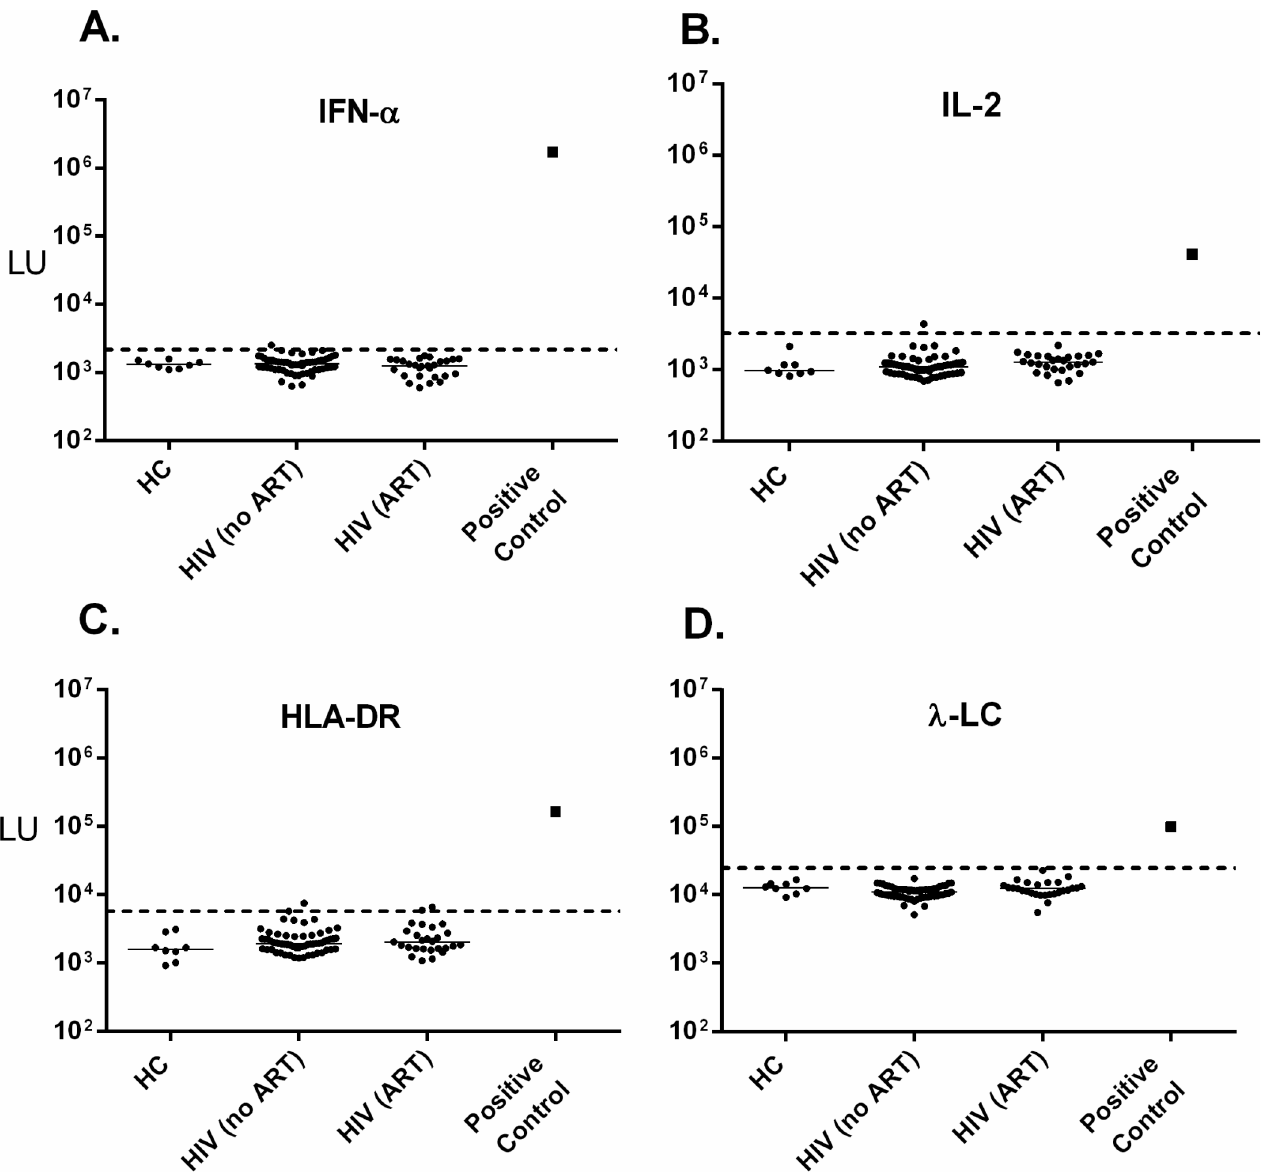
Fig 3. Lack of autoantibodies against IFN- α , IL-2, HLA-DR, and λ -LC in HIV-infected subjects. Autoantibody levels in LU as determined by LIPS are shown for (A) IFN- α , (B) IL-2, (C) HLA-DR, and (D) λ -LC on the y-axis using a log 10 scale. The LU value for each of the positive control antibodies (closed squares) used to validate the assays is shown in its respective plot. The dotted line represents the cut-off value for determining seropositivity.